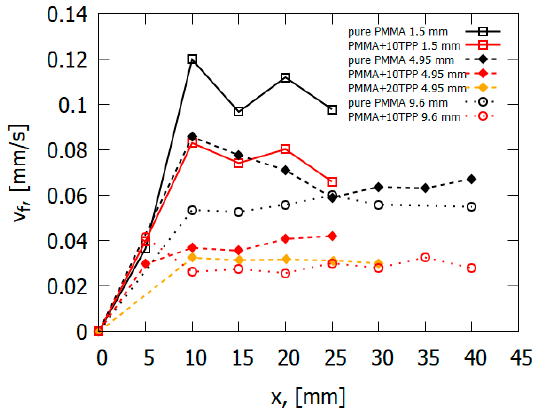
Figure 13. The downward flame ‐ spread rate as a function of the distance from the slab edge.